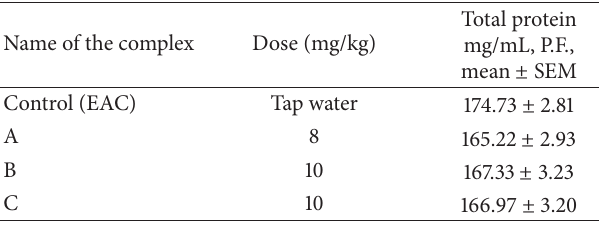
Table 14: The summary of the results of minimum inhibitory concentration (MIC) of test